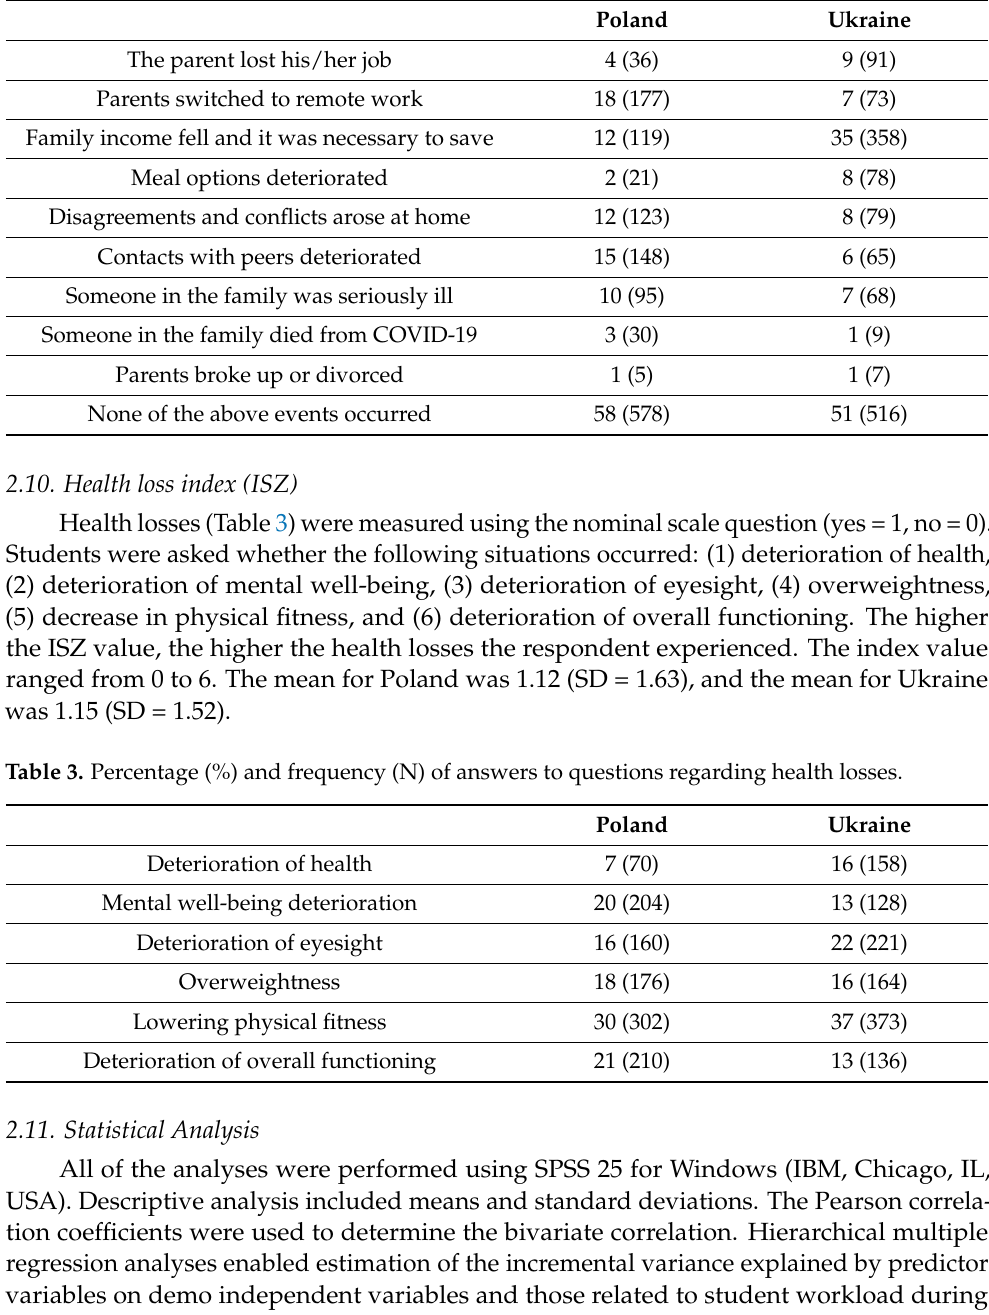
Table 2. Percentage (%) and frequency (N) of answers to questions regarding the negative effects of the pandemic.